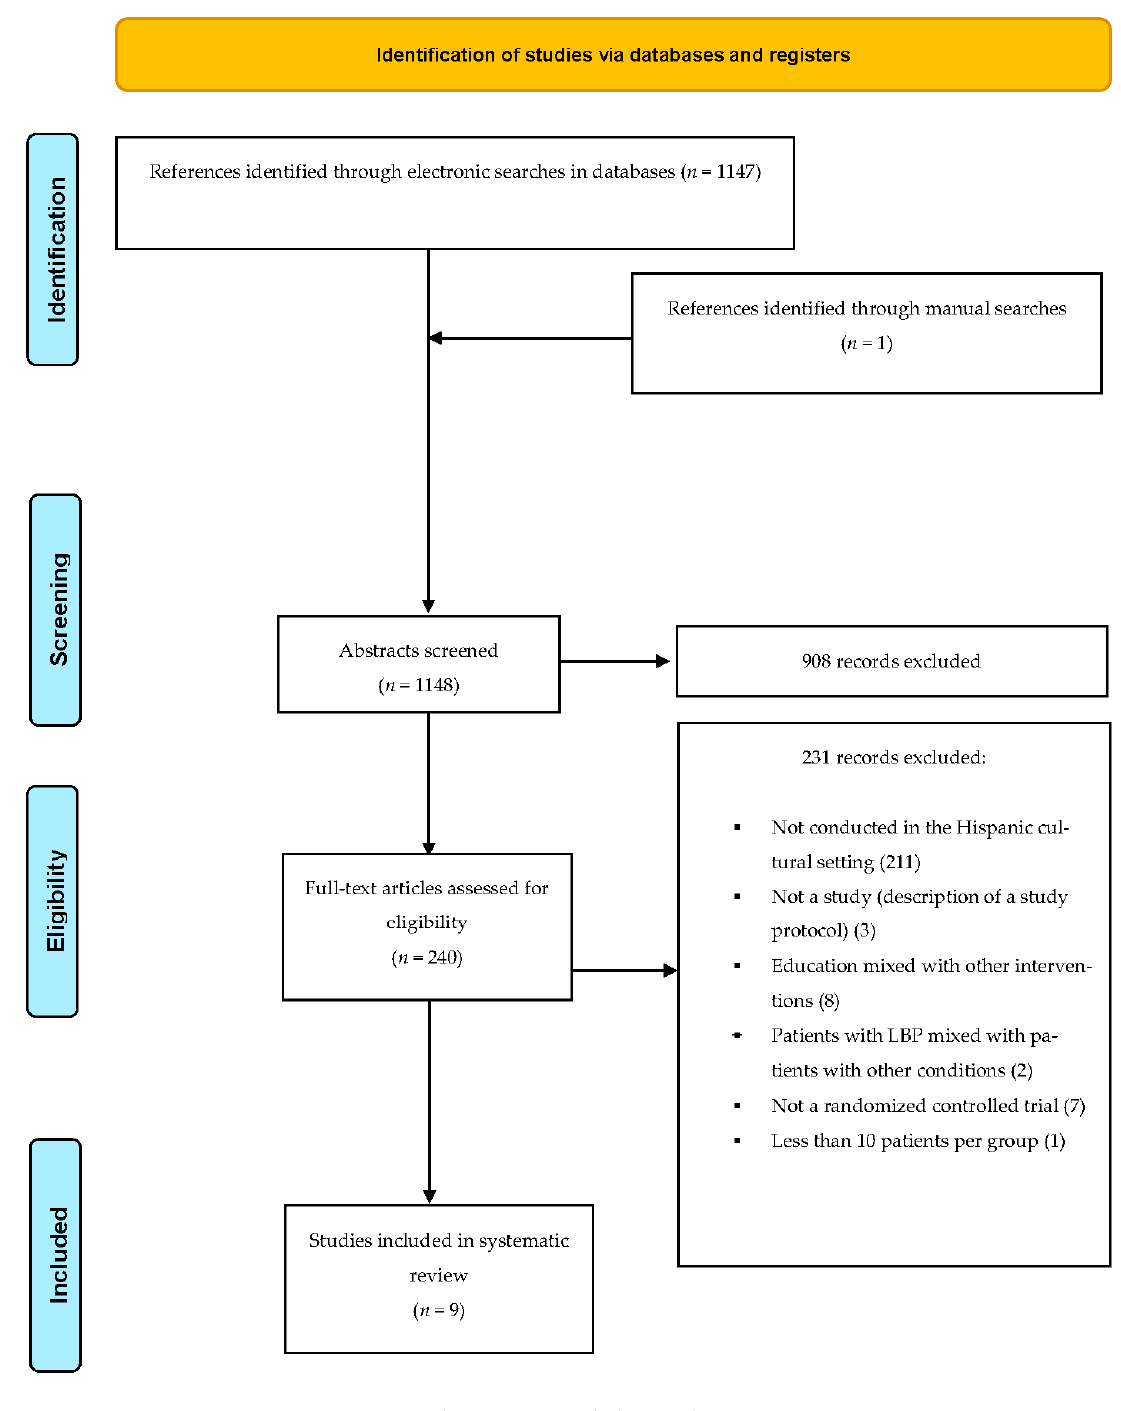
Figure 1. PRISMA Flow Diagram of This